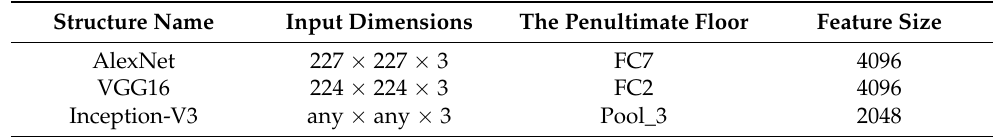
Table 1. The architectures of the